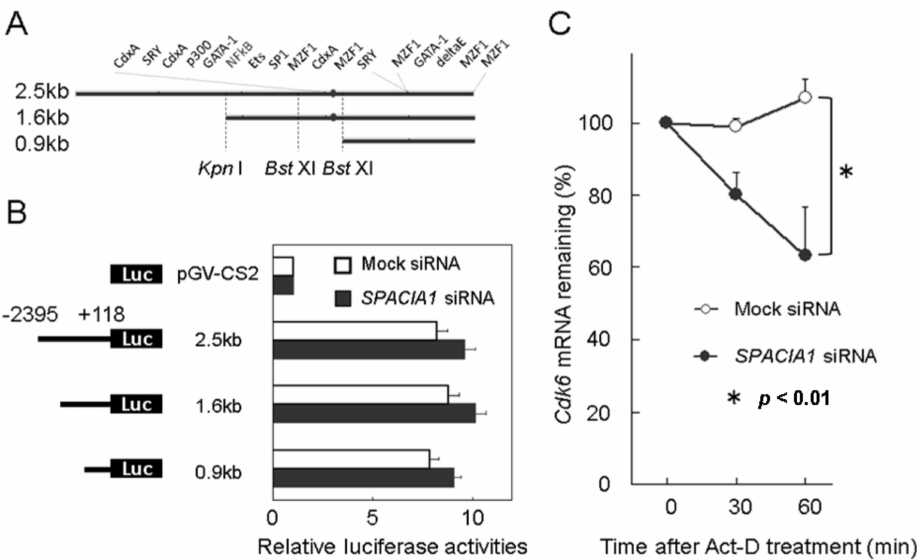
Figure 5. ( A ) Schematic representation of the cdk6 proximal promoter region with restriction